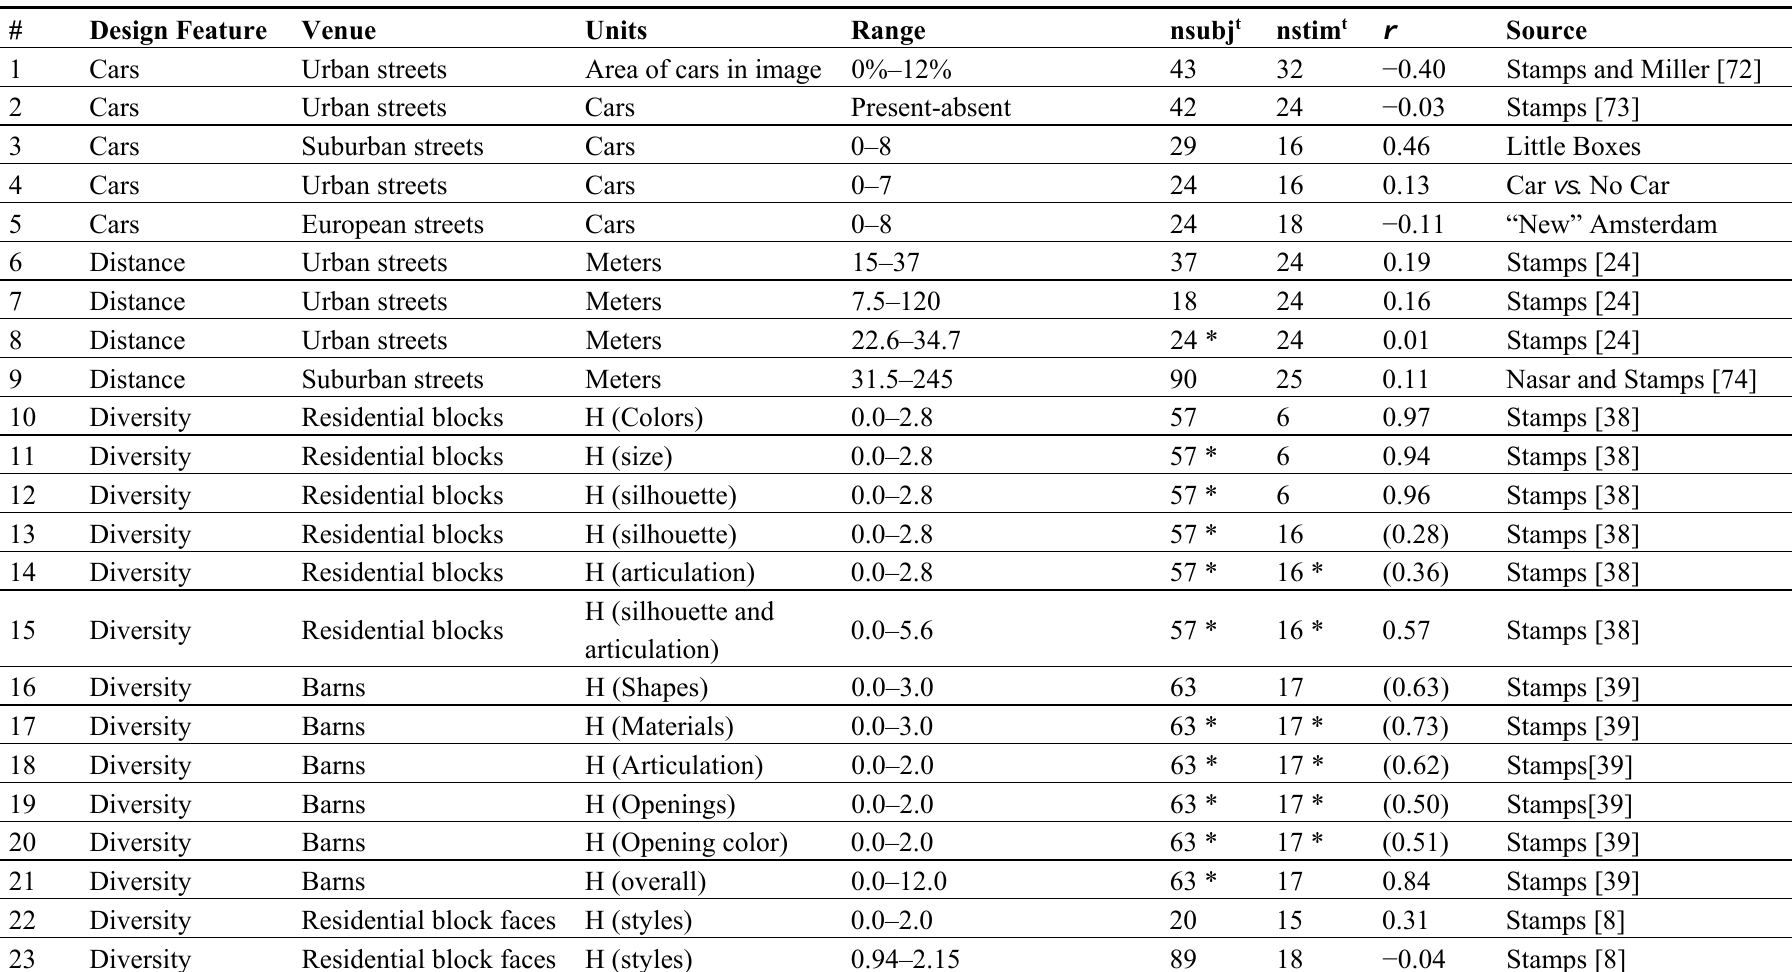
Table A1. The effect size data for contextual urban design guidelines. The dependent variable is the visual appeal of a